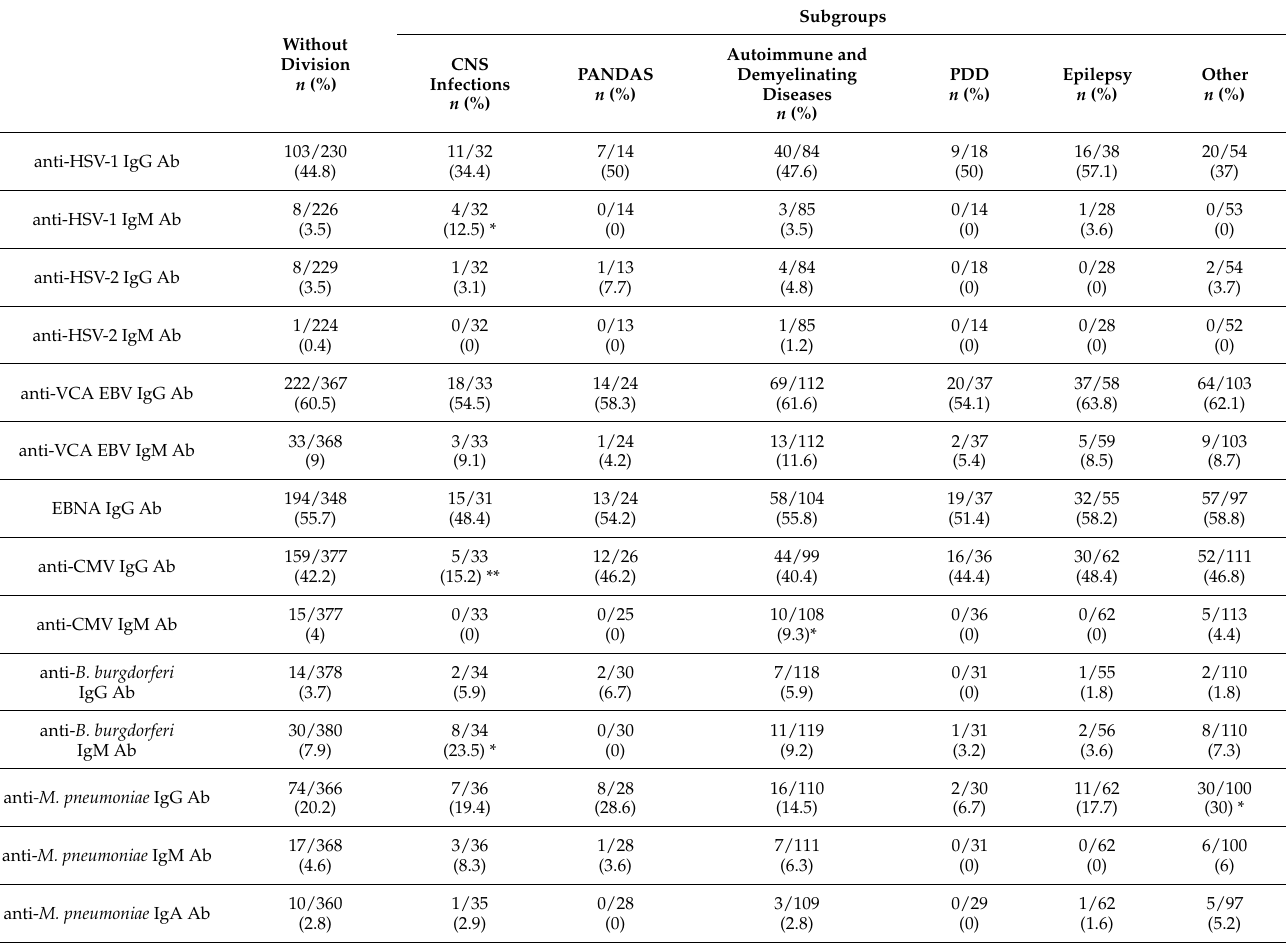
Table 4. Results of selected infective agents’ diagnostics in the research group with and without